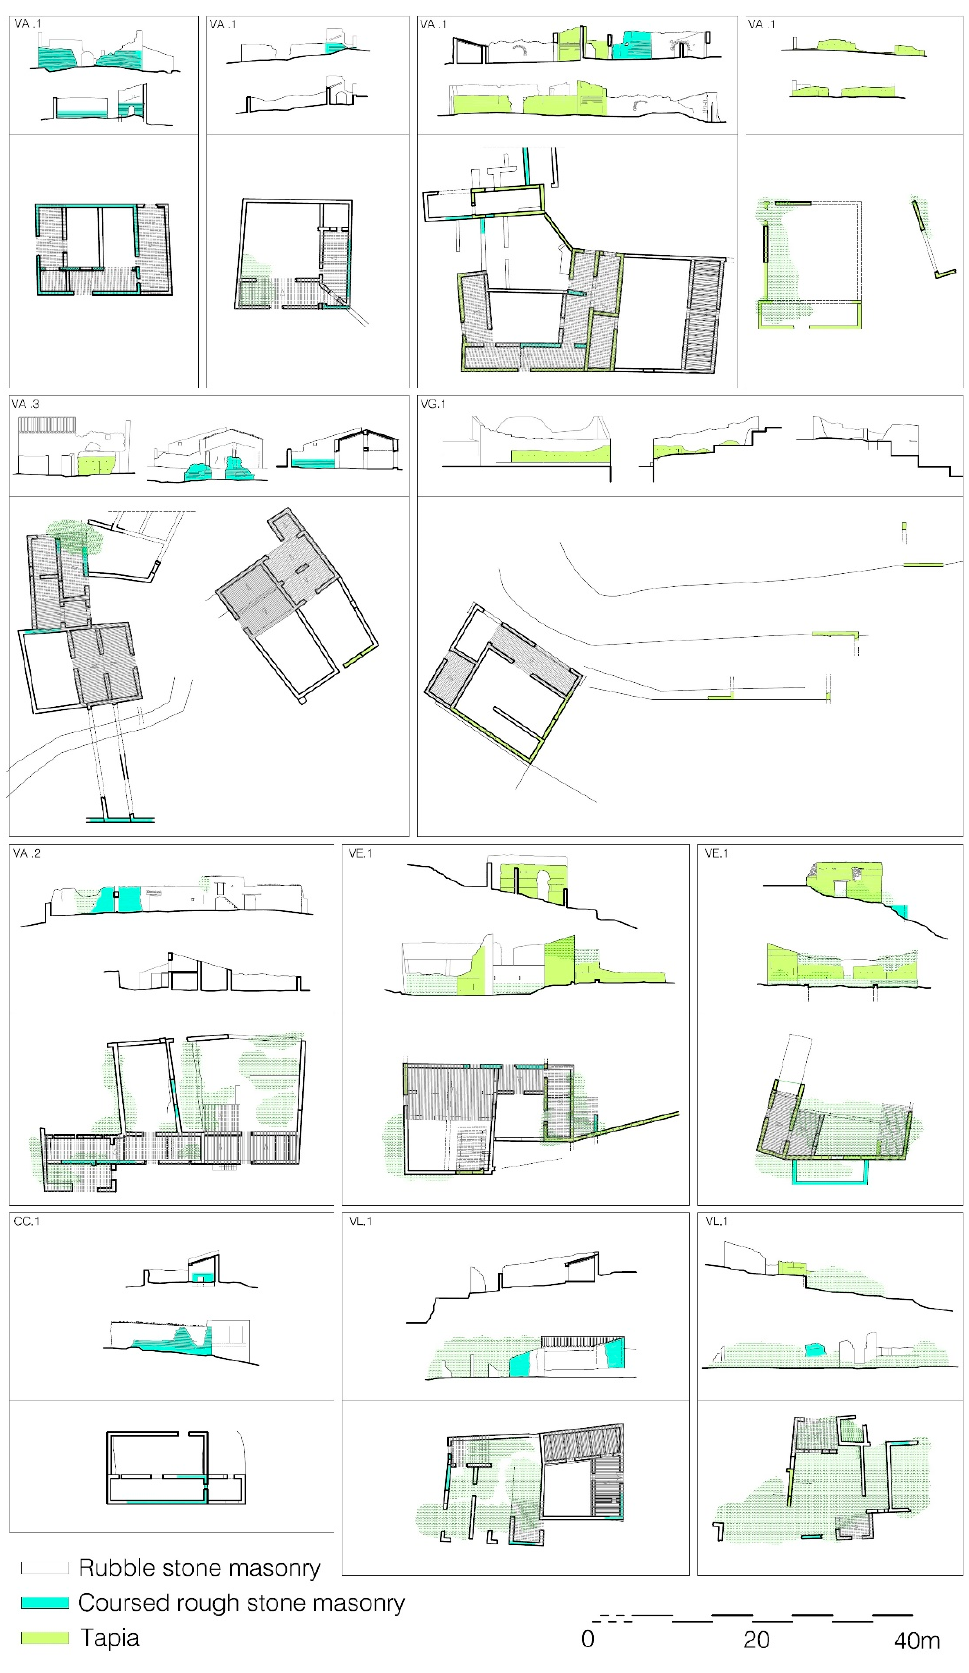
Figure 10. Sections, elevations, and floor plans with detected wall fabrics. Selected cases. Vall d’Alcalà ( VA ): 1 Atzuvieta (1), Benialí (2), Cariola (3). Castell de Castells ( CC ): Aialt (1). Vall d’Ebo ( VE ): Cairola (1). Vall de Gallinera ( VG ): Solana Benissili (1). Vall de Laguar ( VL ): Isbert (1).